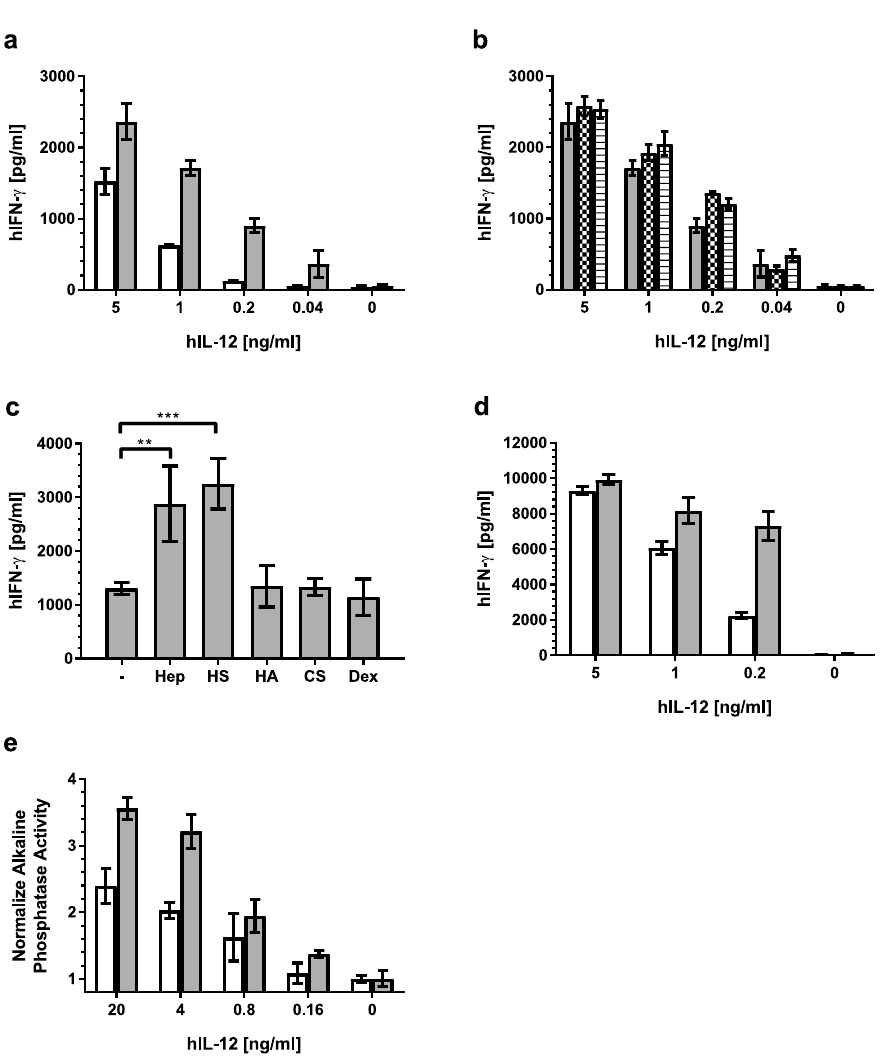
Figure 1. Effect of heparin and other GAGs on hIL-12 bioactivity. ( a ) hIFN- γ production by NK-92MI cells when incubated with media containing hIL-12 alone (white bars) or with 10 µ g/ml heparin (gray bars) was quantified using ELISA. Heparin significantly enhanced hIL-12 bioactivity (p < 0.0001 vs. hIL-12 alone via two-way ANOVA) ( b ) hIFN- γ production by NK-92MI cells when heparin (10 µ g/ml) was added to NK- 92MI cells at the same time as hIL-12 (gray bars), 30 mins prior to hIL-12 (checkered bars) or 30 mins after hIL-12 (horizontal). The order of heparin addition had no significant effect on hIL-12 activity (p > 0.05 for all comparisons within each hIL-12 concentration via two-way ANOVA with Tukey’s post hoc correction). ( c ) hIFN- γ production by NK-92MI cells cultured in media containing 200 ng/ml hIL-12 alone ( − ) or with heparin (Hep), heparin sulfate (HS), hyaluronic acid (HA), chondroitin sulfate (CS), or dextran (Dex) at 10 µ g/ml was quantified using ELISA. Asterisks indicate a significant difference between indicated groups ( * = p < 0.01 and *** = p < 0.001 via one-way ANOVA with Dunnett’s post hoc correction). ( d ) hIFN- γ production by PBMCs when incubated with media containing hIL-12 alone (white bars) or with 10 µ g/ml heparin (gray bars) was quantified using ELISA. Heparin significantly enhanced hIL-12 bioactivity (p < 0.0001 vs. hIL-12 alone via two-way ANOVA). ( e ) Alkaline phosphate activity by HEK-Blue ™ IL-12 cells in response to incubation with media containing hIL-12 alone (white bars) or with 10 µ g/ml heparin (gray bars) was determined in accordance with manufacturer’s instructions. Heparin significantly enhanced hIL-12 bioactivity (p < 0.0001 vs. hIL-12 alone via two-way ANOVA). All data are represented as mean ± standard deviation from triplicate samples. All experiments were repeated at least twice with similar